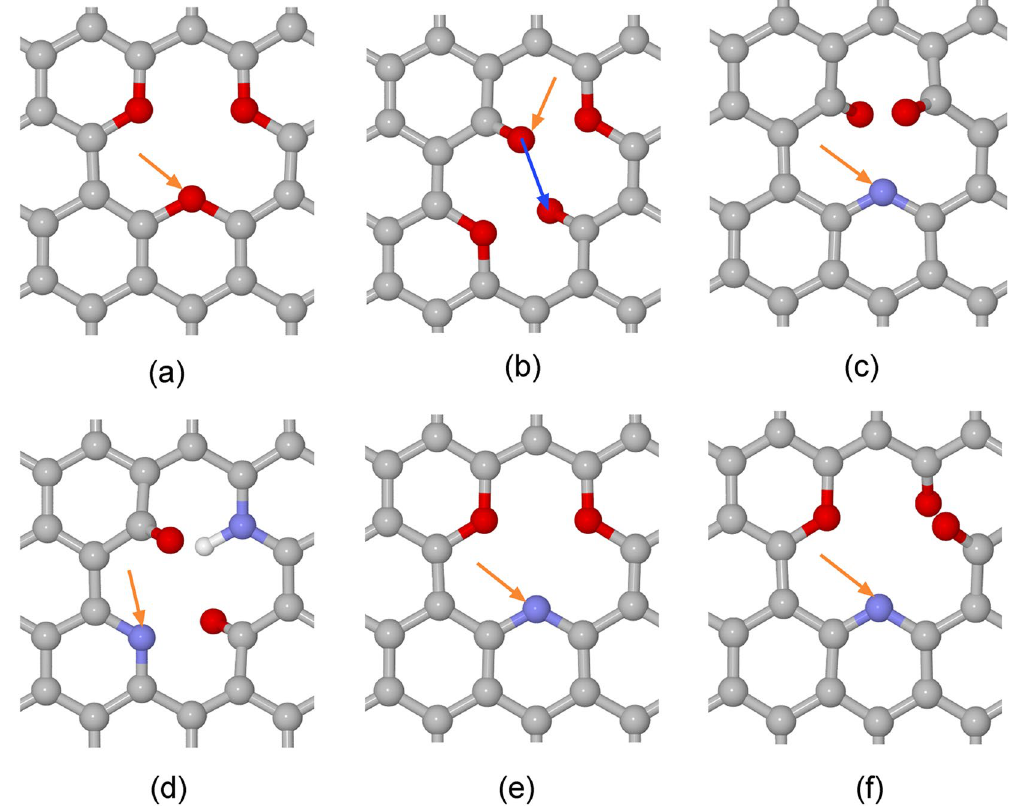
Figure 2. Different local structures considered for proton transport: ( a ) T2-V4-O3, ( b ) T1-V4-O4, ( c ) V2- N1O2, ( d ) T1-V4-N2O2H1, ( e ) T2-V4-N1O2, ( f ) T2-V4-N1O3. NxOyHz: “x”, “y” and “z” are the number of N, O and H atoms at a vacancy site, respectively. “V2” and “V4” are graphene vacancies with two and four carbon atoms removed, respectively. “T1” and “T2” are employed for distinguishing two different types of “V4”. More details are in Supporting Information (SI1). The white, red, grey and blue spheres are hydrogen, oxygen, carbon and nitrogen atoms, respectively. The yellow arrow indicates how a proton transfers from the bulk solution to the surface, and the blue arrow indicates how a proton relays between two sites across the